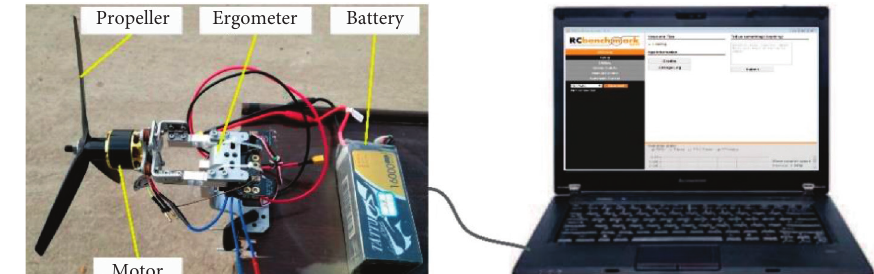
Figure 4: Rotor test.